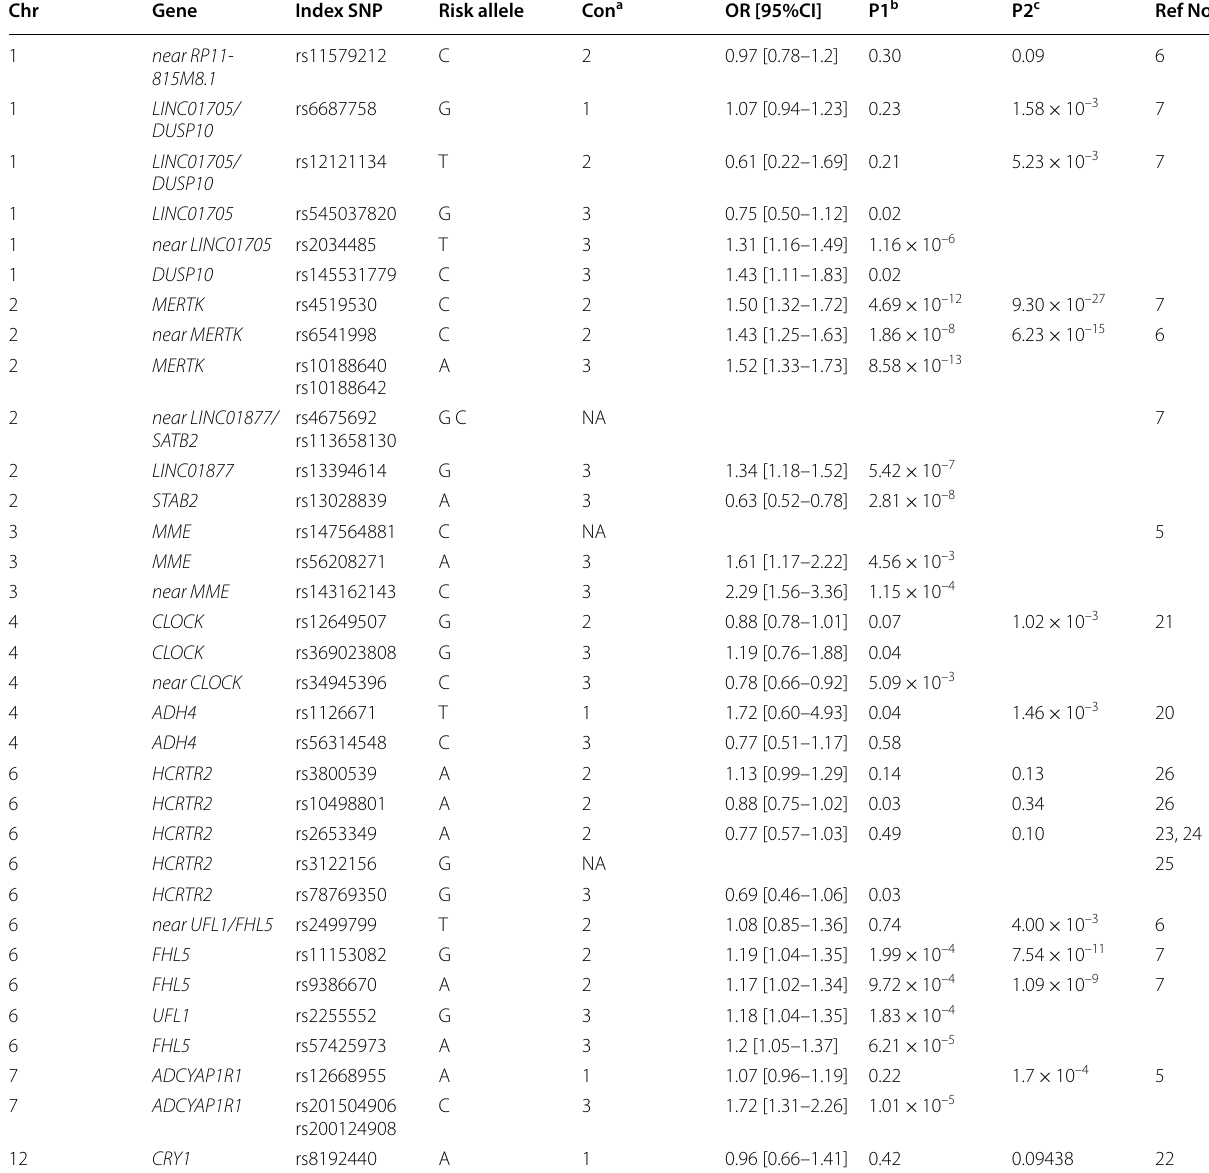
Table 2 The Association of previously reported cluster headache loci in the current